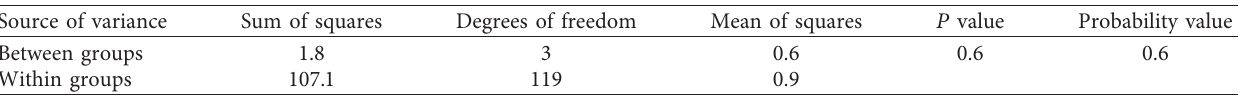
Table 10: Results of the one-way analysis of variance for the measure of the quality of e-learning programs for students of the variable of program type.